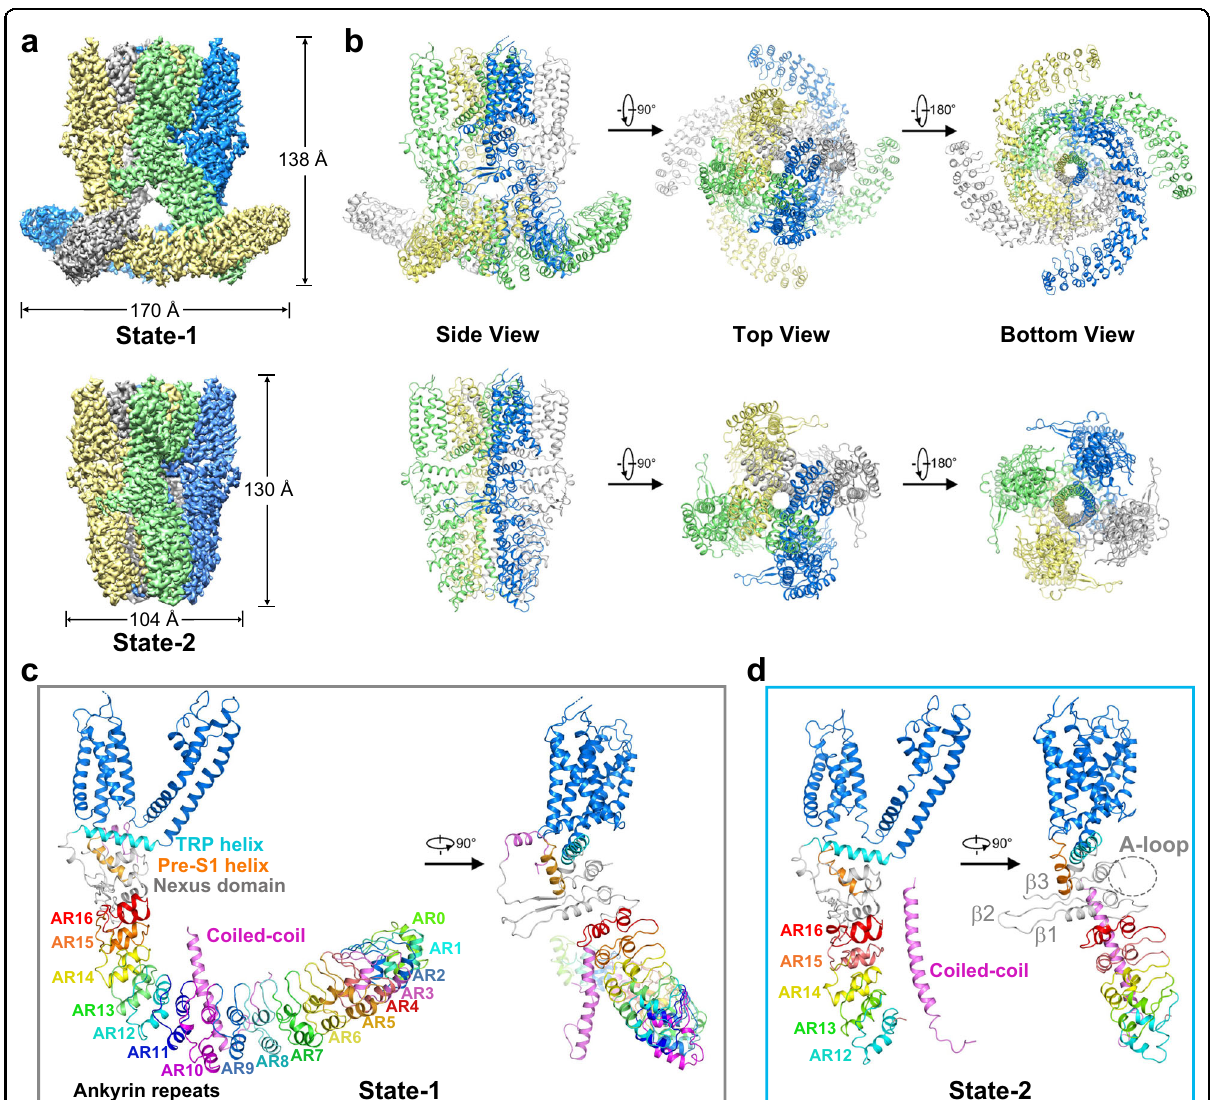
Fig. 1 Structure determination of the Drosophila TRPA1-A isoform. a EM density maps of dTRPA1-A in two distinct states, with an overall resolution of 3.2 Å for state-1 (upper) and 3.0 Å for state-2 (lower). A side view is shown here with each of the four subunits colour-coded. b Cartoon representations of the dTRPA1-A structures in two states. Three views are shown here with each subunit colour-coded. c Overview of the subunit structure of dTRPA1-A in state-1. Seventeen ARs, AR0 – AR17, are shown in this state with colour coding. The transmembrane domain is shown in marine blue, and the TRP helix and pre-S1 helix are coloured cyan and orange, respectively. The coiled-coil domain is shown in magenta. d Overview of the subunit structure of dTRPA1-A in state-2. The last fi ve ARs, AR12 – AR16, are visualised in this state with colour coding. The A-loop is indicated by a grey dashed circle. The three β -strands in the nexus domain are labelled β 1 – β